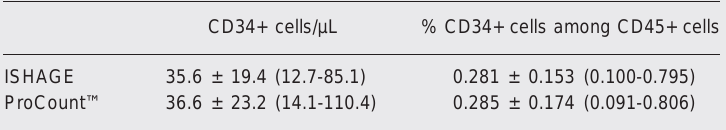
Figure 1. Comparison of two methods for quantitative meas- urement of the absolute number of CD34+ cells/µL in cord blood. Each point represents the re- sults of one cord blood sample, evaluated with the International Society of Hematotherapy and Graft Engineering (ISHAGE) and ProCount™ protocols. The Sta- tistical Package for the Social Sciences (SPSS, version 8) was used and the results were compared by the Student t -test. The correlation was statistically significant (P